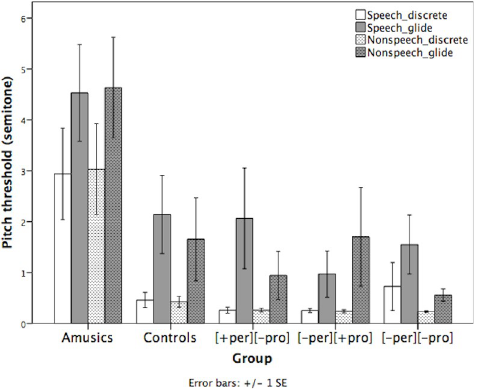
Fig 4. Pitch thresholds of the five groups in the speech and nonspeech stimuli with discrete and gliding pitch (Error bar = ± 1 SE). [+per][-pro]: T2-T5; [-per][+pro]: T4-T6; [-per][-pro]: T2-T5.